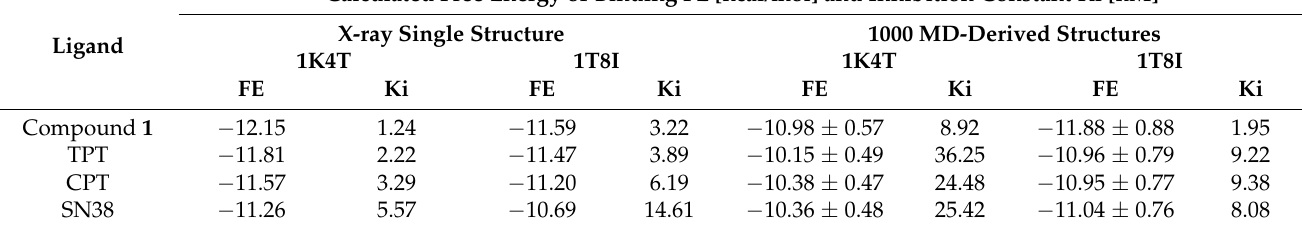
Table 1. Docking analysis with